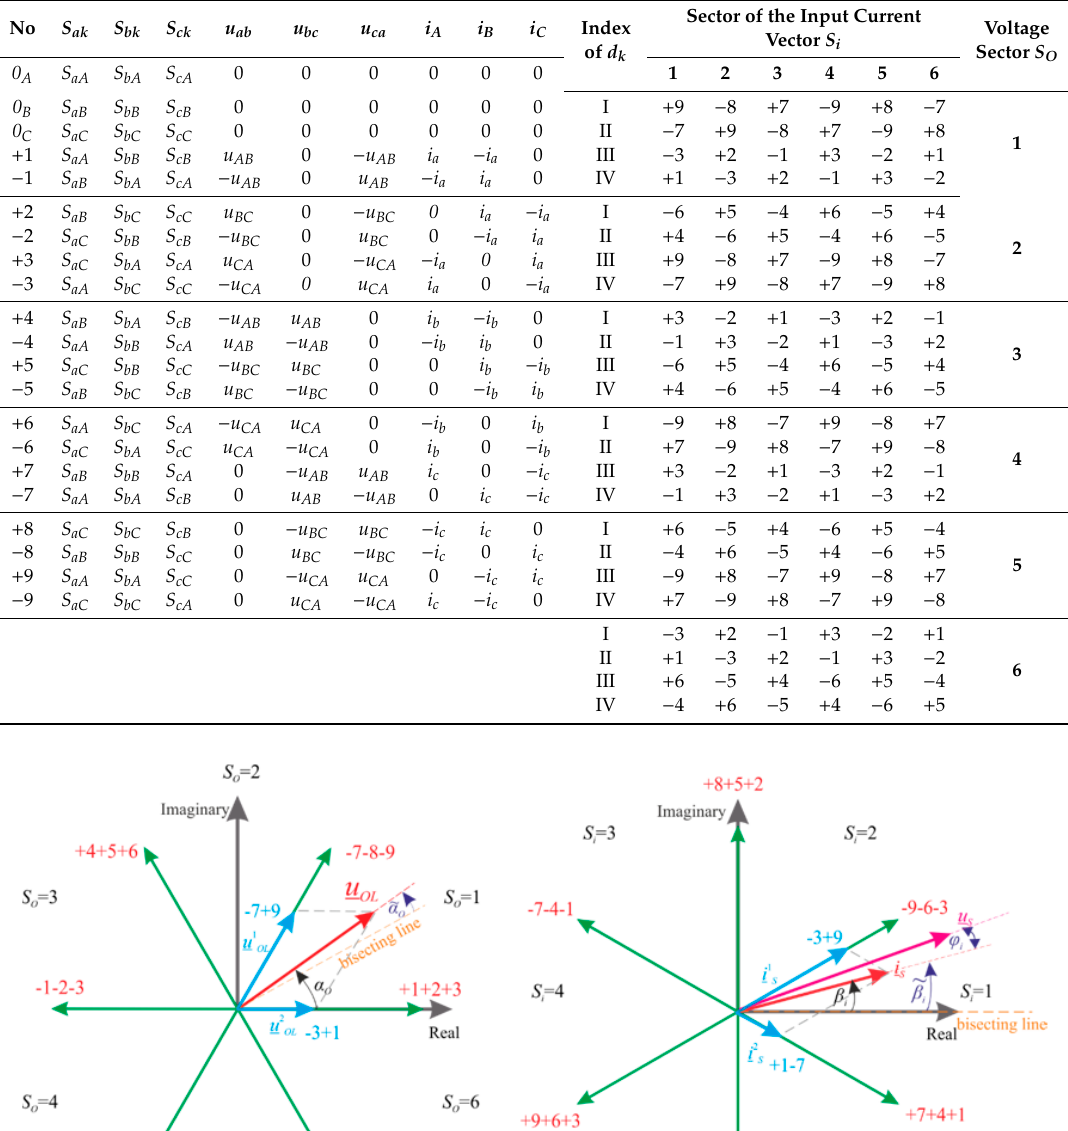
Table 1. Space vector modulation (SVM) vector definition: switch configuration in the MC (left hand side of table); selection of the switching arrangements for individual combination of S O and S i sectors (right hand side of table).